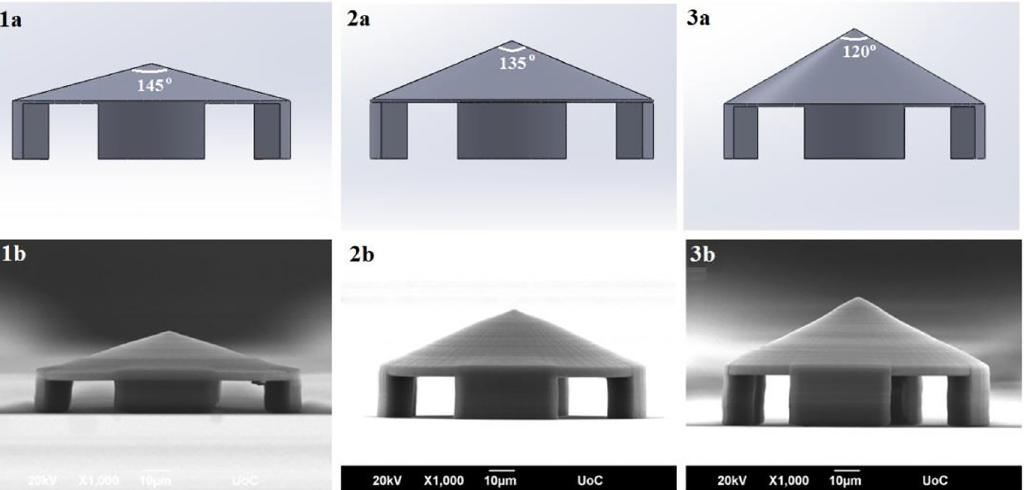
Figure 6: (1a), (2a), and (3a) present the CAD images of 100 μ m-diameter axicons with inset angles of 145 ° , 135 ° , and 120 ° , respectively. Scanning electron microscopy (SEM) images of fabricated axicons are presented in (1b), (2b), and (3b).